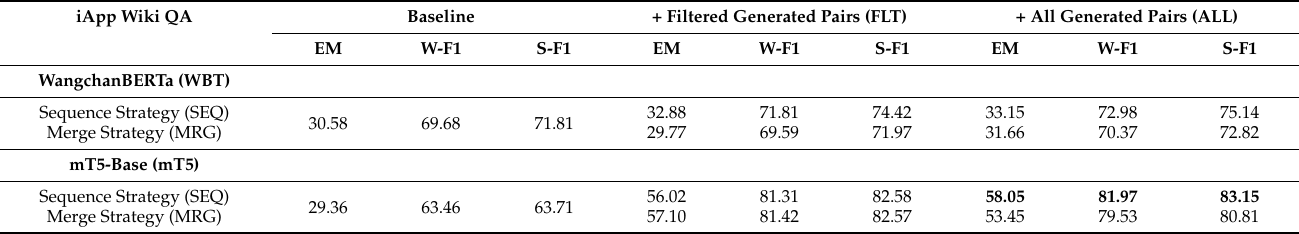
Table 5. The experiment result of our method compared to baseline models of iApp Wiki QA. (EM, W-F1, and S-F1 refer to Exact Match, word-level F1 and syllable-level F1 respectively. Boldface refers to the